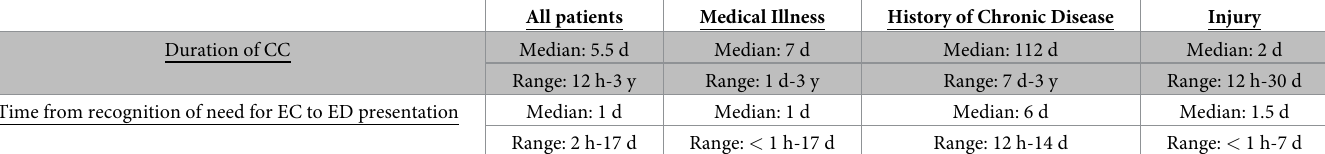
Table 3. Patients’ delays in ED presentation.